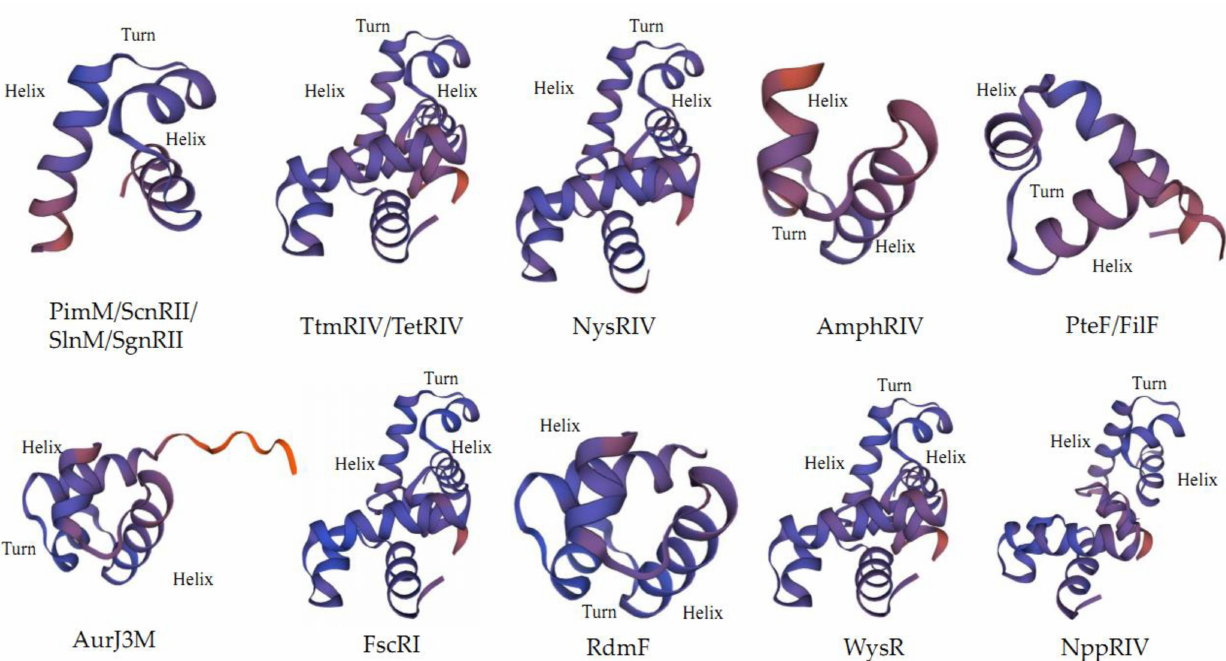
Figure 5. Simulated secondary structures of C-terminal HTH motif of PAS-LuxR family regulators by SWISS-MODEL on https://swissmodel.expasy.org/, accessed on 25 July